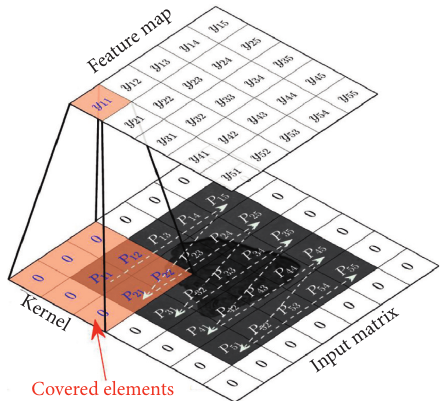
Figure 2: Convolution operation [14].